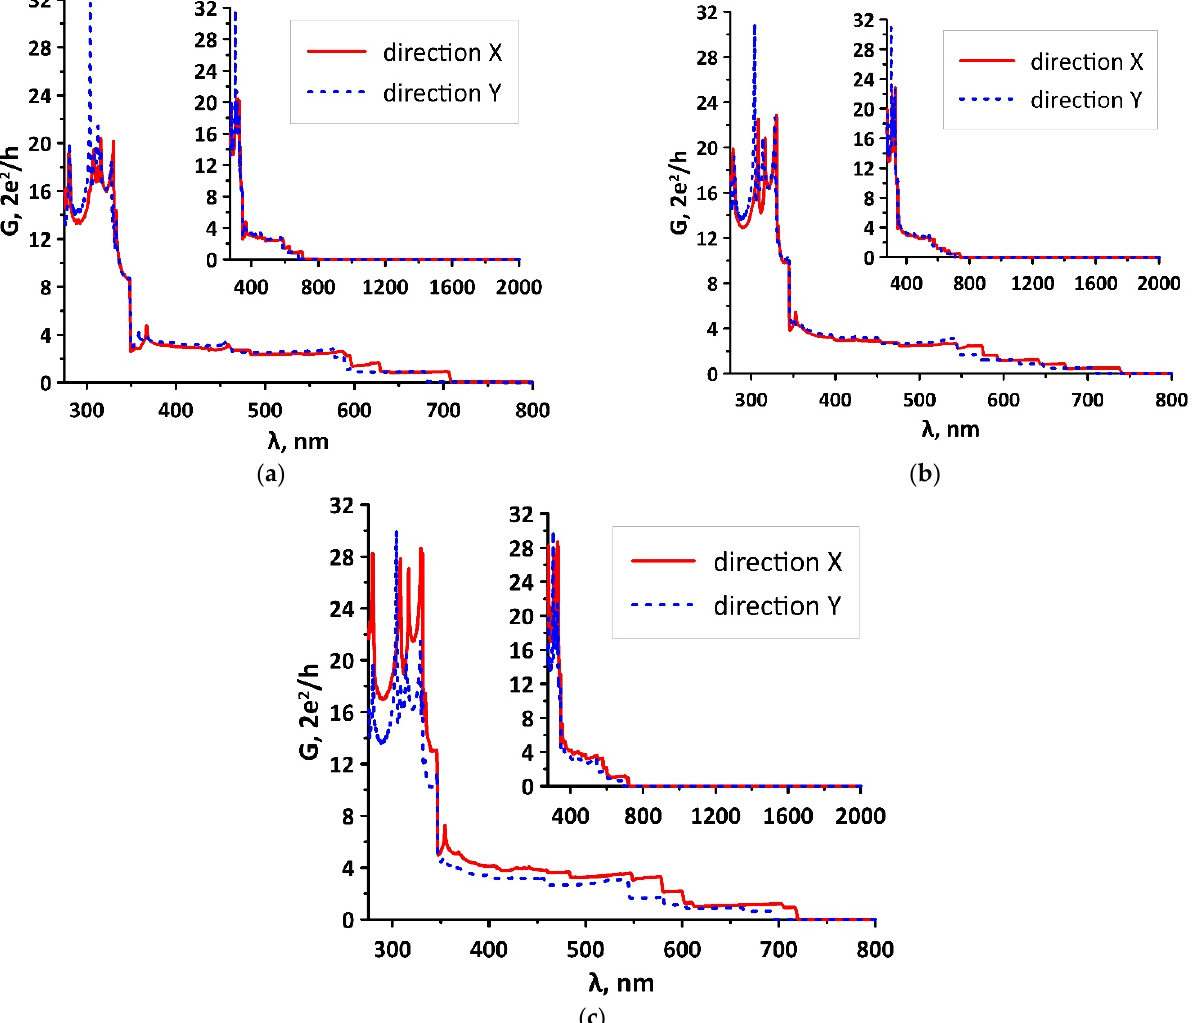
Figure 4. The dynamic conductivity spectra of van der Waals ZnO/BlueP/ZnO heterostructure with AAA ( a ), ABA ( b ), and ABC ( c ) stacking configurations for two cases of electromagnetic wave polarization (along the X and Y axes).